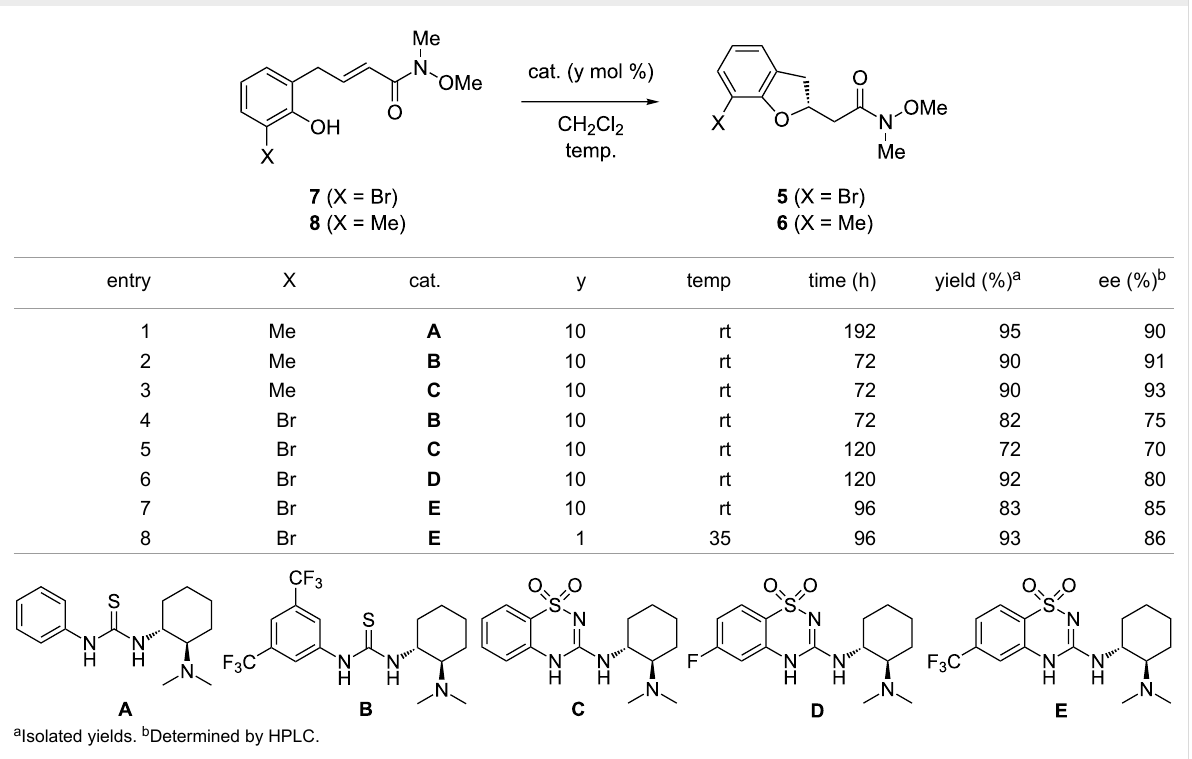
Table 1: Optimization of asymmetric intramolecular oxa-Michael reaction.